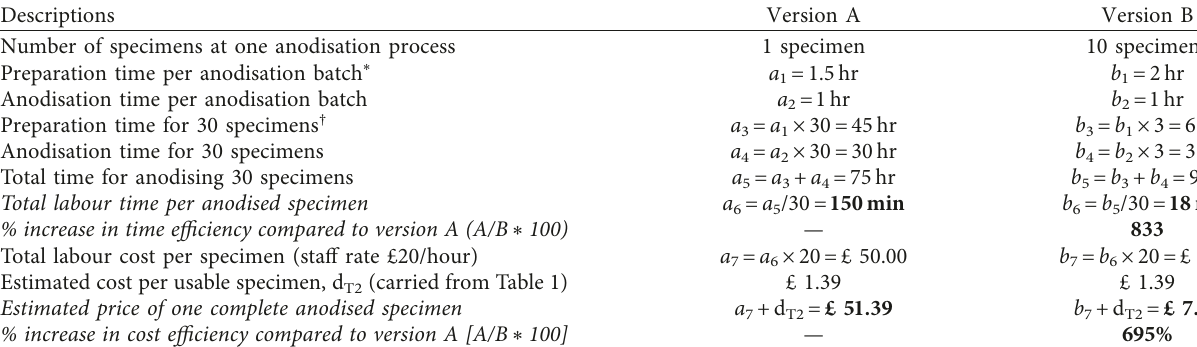
Table 2: Time and cost analysis comparing the two anodisation device designs. Wire-cut EDM (cutting Method 2) was adopted for calculating the costs due to its overall advantages. Staff rate of £20 per hour was incorporated as a typical wage for technical staff members trained to graduate level in the UK (prices current June